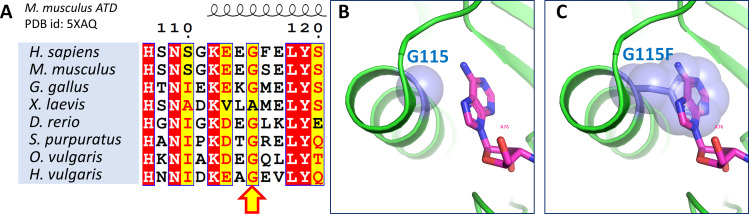
G115F mutant of ATD is inactive.(A) Structure-based sequence alignment of ATDs from different organisms showing the conserved Gly115 in the adenine binding pocket of ATD. Adenine binding pocket of ATD (adenine modeled by overlapping MmATD (PDB id: 5XAQ) and ligand bound PfDTD (PDB id: 4NBI)) showing (B) G115 in and (C) G115F in spheres, which clearly depicts the steric exclusion of A76 from the ATDs active site.